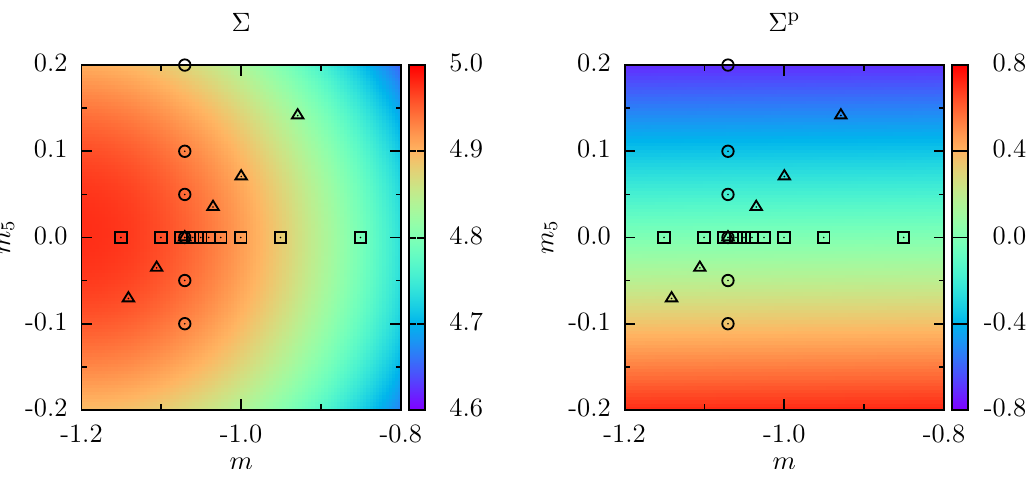
Figure 9 . Left: the (unrenormalized) chiral condensate Σ and fit to polynomial of second order. Right: the parity condensate Σ p and fit to a plane. The squares, triangles and circles correspond to α = 0 ◦ , 45 ◦ and 90 ◦